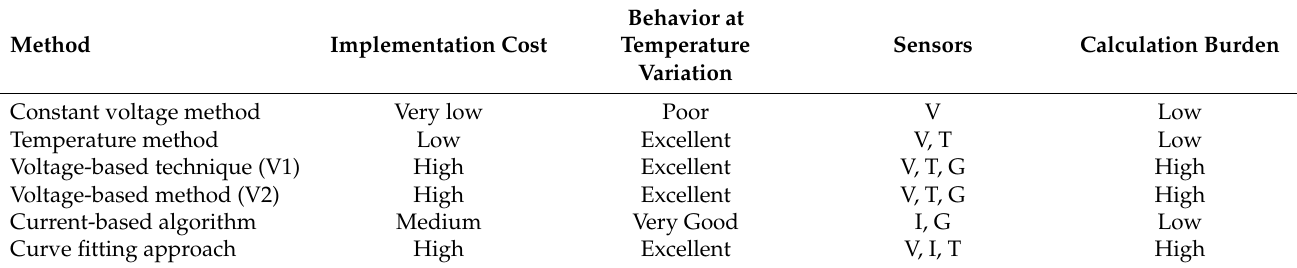
Table 5. Brief comparison among the model-based MPPT